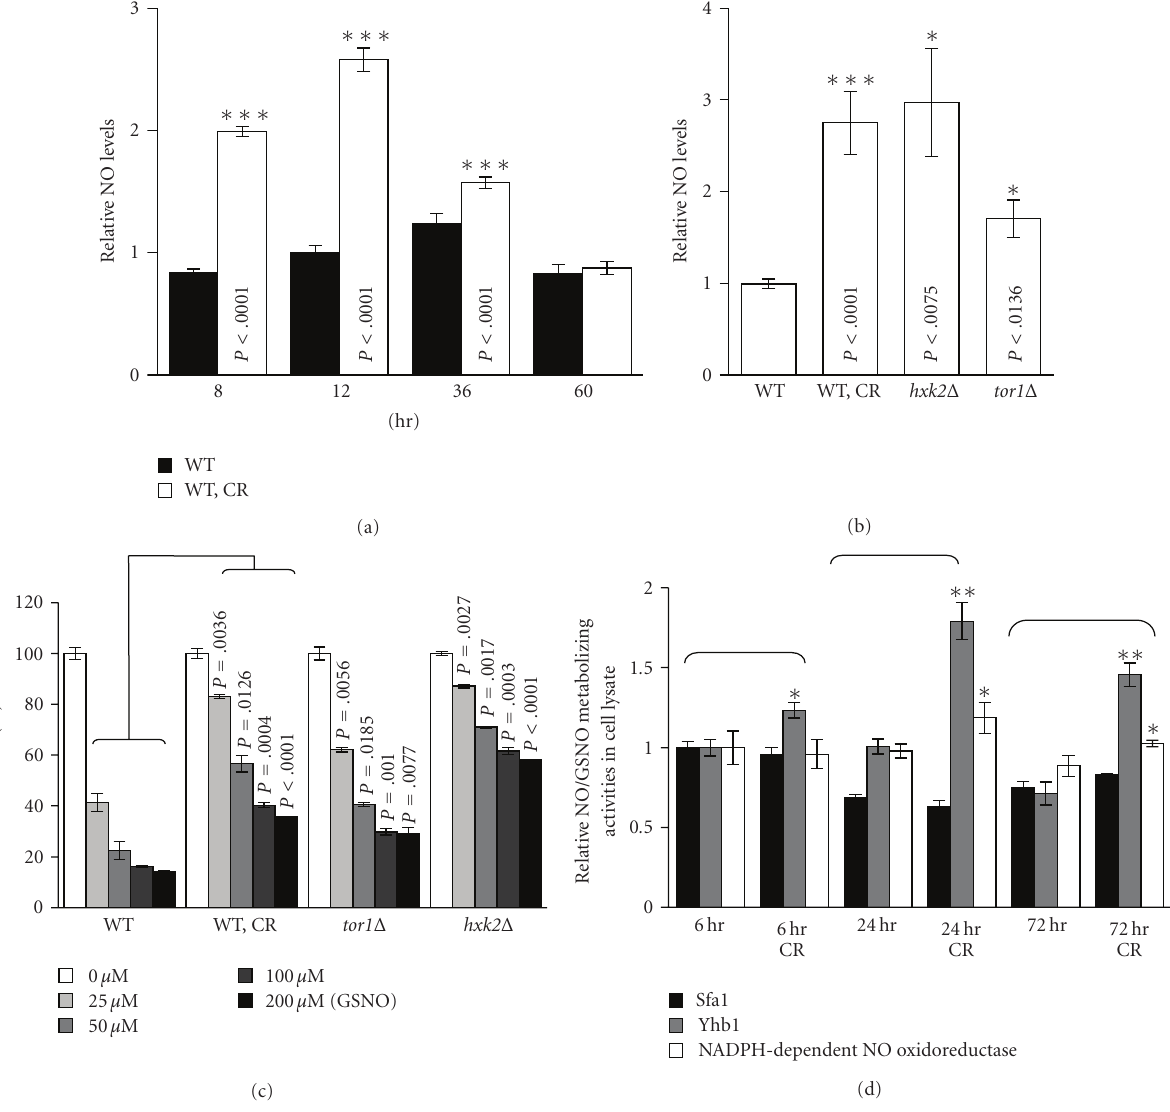
Figure 1: Calorie restriction (CR) and CR genetic mimics increase nitric oxide (NO) levels and confer resistance to nitrosative stress in yeast cell. (a) CR increases NO-related signals during early growth stage. (b) Long-lived tor1 Δ and hxk2 Δ mutants also show increased NO- related signals. (c) CR and CR mimics confer resistance to S -nitrosoglutathione- (GSNO-) induced toxicity. Results show percentages (%) of growth normalized to no treatment controls after treated with GSNO at indicated concentrations for 20hr. (d) Yeast cells grown in CR show increased NO metabolizing activities determined in cell lysates. P values are calculated comparing CR cells and the tor1 Δ or hxk2 Δ mutants to WT control. WT: BY4742 wild-type control; CR: 0.5% glucose; Δ : gene deletion. One representative set of three independent experiments is shown. Error bars denote standard